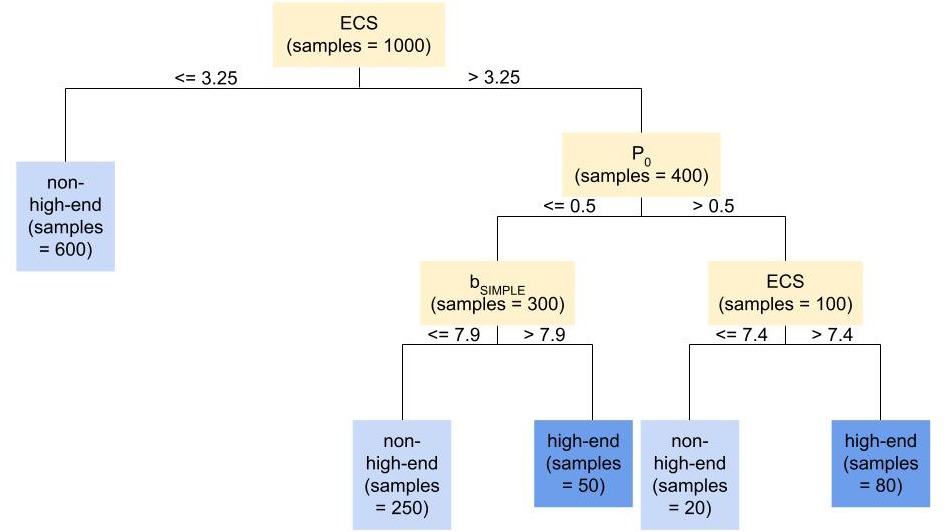
Figure 1. Hypothetical decision tree demonstrating the general decision tree structure using BRICK model parameters and our high-end and non-high-end classification outcomes. Since we used a maximum depth of 3 as the stopping criterion, the tree made three levels of splits before stopping to create leaf nodes. Table 1. Hyperparameter values of the best estimator from the grid search.